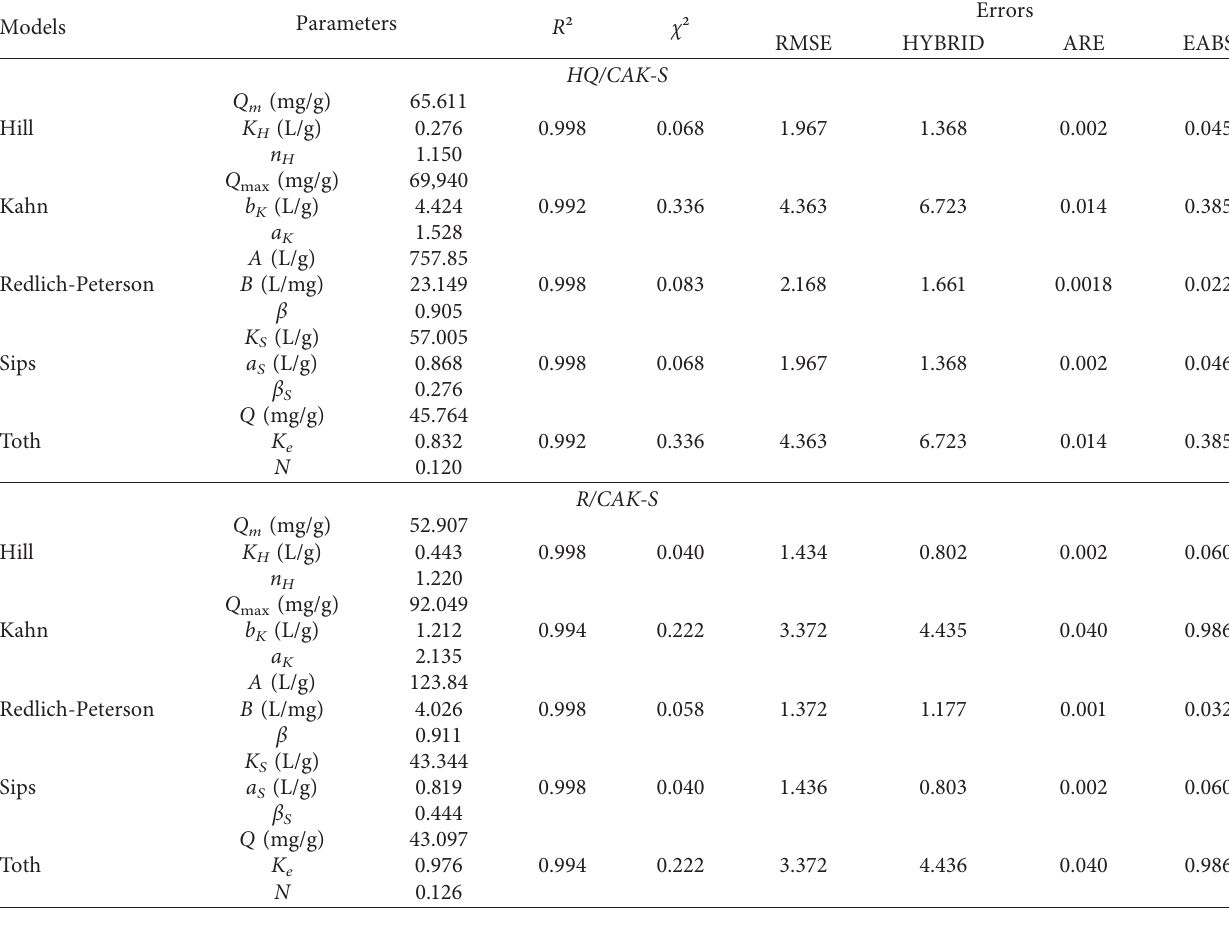
Table 10: Adsorption of hydroquinone and resorcinol: nonlinear fitting analysis for three-parameter isotherms (see equations in Tables 3 and